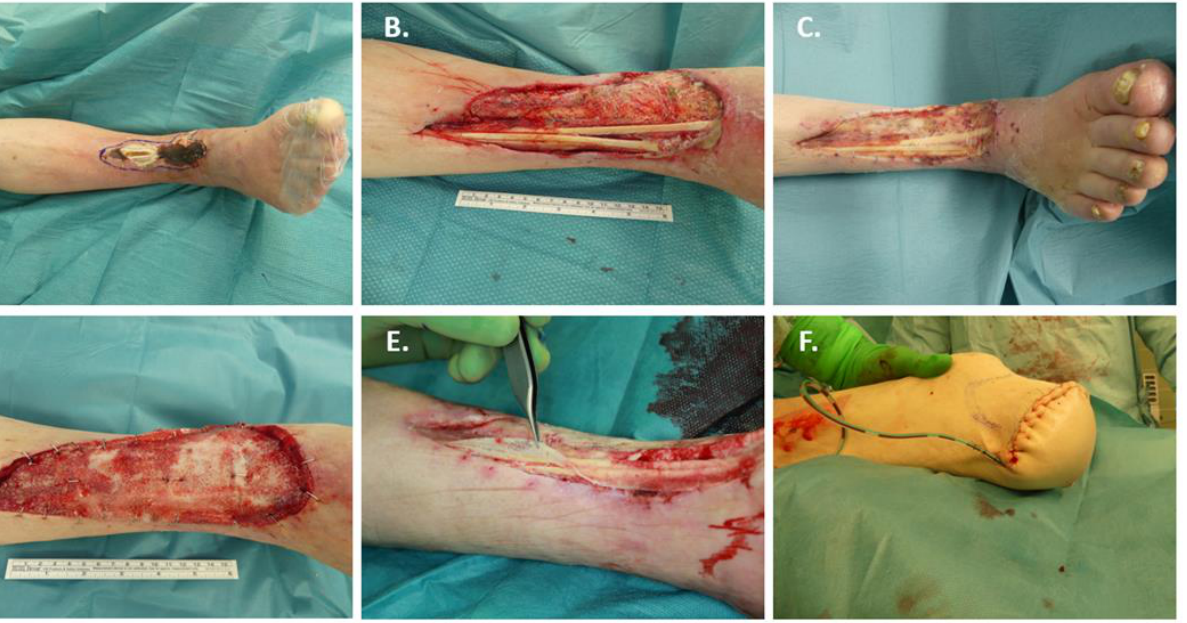
Figure 7. A case of a non-healing, chronic lower leg ulcer treated with BTM. A 82-year-old male was admitted with a chronic wound in the area of the right ventral lower leg: ( A ) Wound situation on admittance; ( B ) Wound situation and defect size after surgical debridement; ( C ) Wound situation after implantation of BTM; ( D ) Increasing visible vascularization of BTM after 21 days; ( E ) Failure to integrate BTM after 21 days; ( F ) Transtibial amputation according to Burghess, which healed completely.